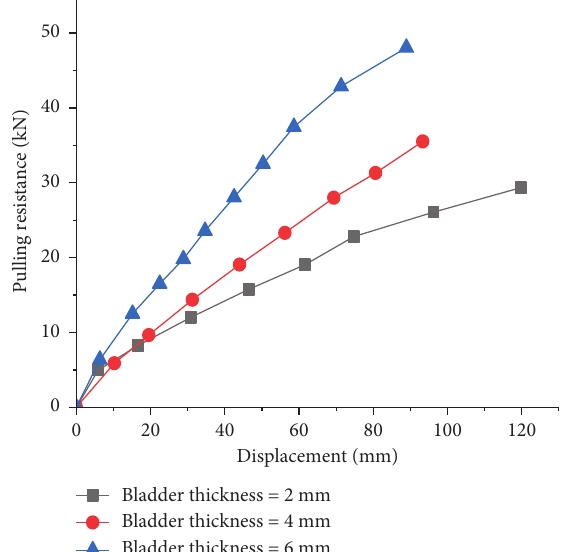
Figure 7: The pulling force vs. displacement relationship under different bladder thickness